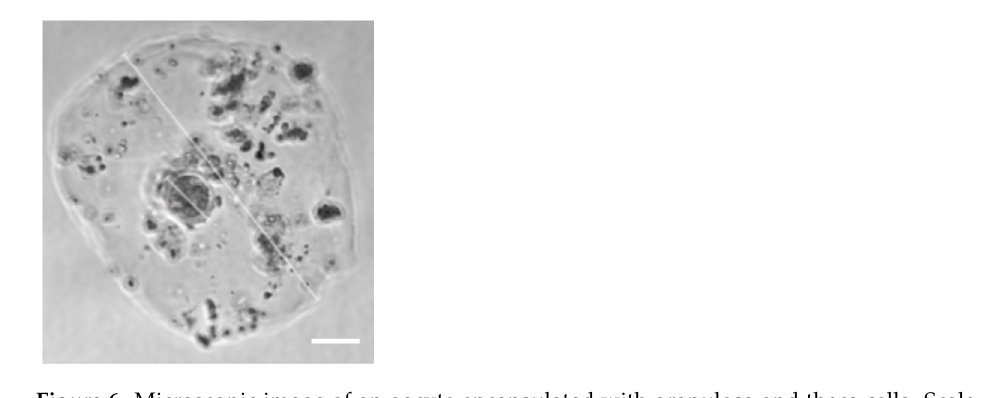
Figure 6. Microscopic image of an oocyte encapsulated with granulosa and theca cells. Scale bar, 100 μ m.